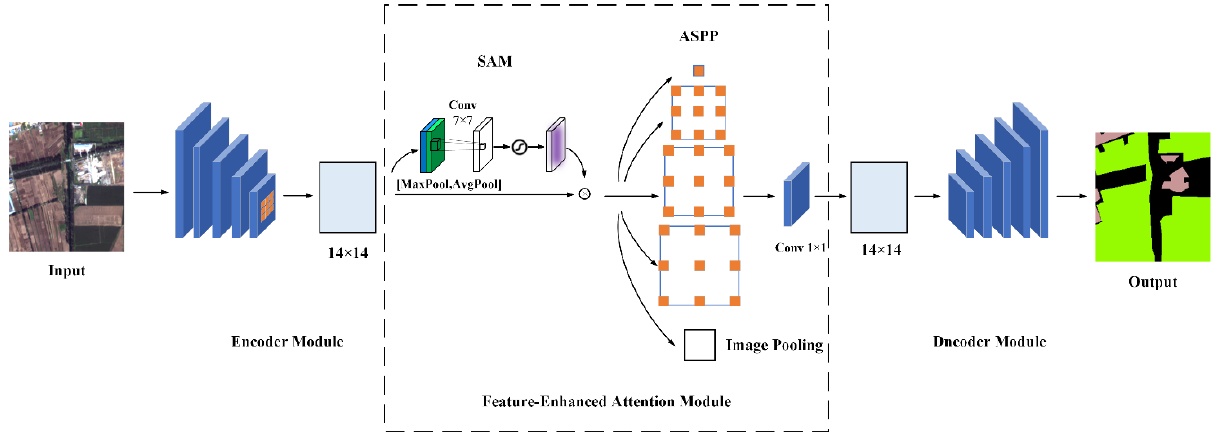
Figure 1. Model structure of VEDAM.